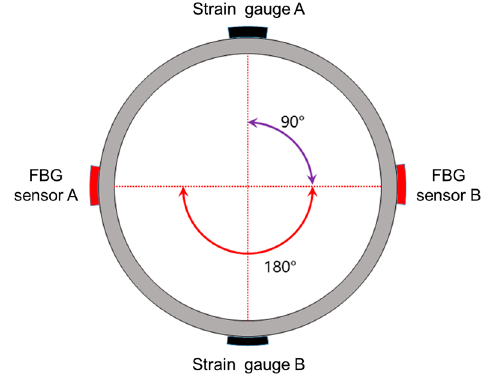
Figure 8. Cross-sectional diagram of the sensor casing and the sensor position. The WSS-SG sample was attached in the direction vertical to the casing (loading direction) and the OR-SG sample, which is the 3-axis sensor, was arranged such that the 1- axis direction of each sensor was aligned with the load application direction (0°), as shown in Figure 9.